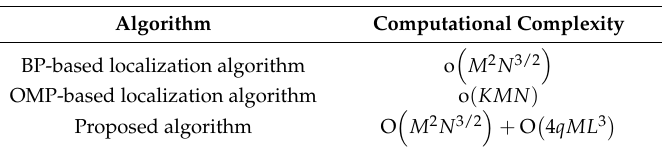
Table 1. Computational complexity comparison.